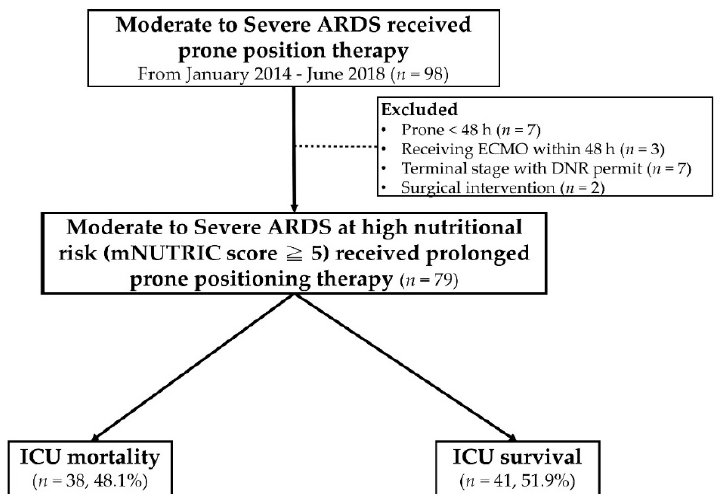
Figure 1. Study flowchart. ARDS: acute respiratory distress syndrome; ECMO: extracorporeal member oxygenation; DNR: do not resuscitate; ICU: intensive care unit. Table 1. Demographic characteristics, severity scores, comorbidities, and clinical outcomes of pa- tients with moderate to severe ARDS receiving prolonged PP therapy in the ICU.